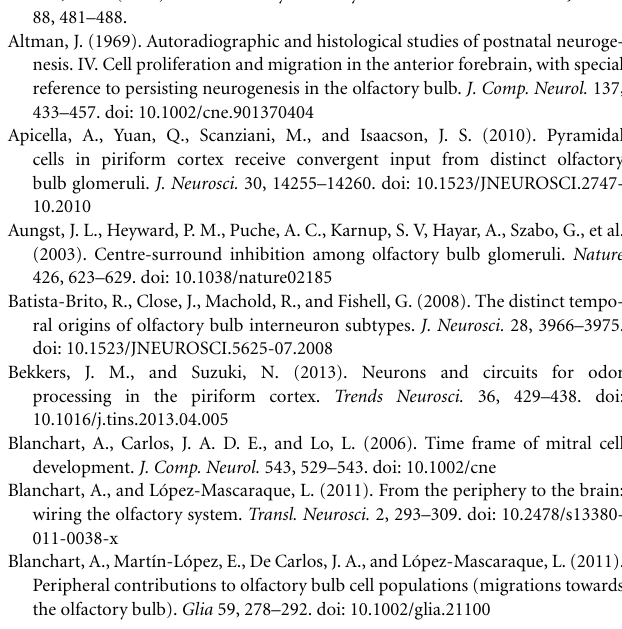
in utero electroporation of different plasmids with the UbC-Star Track method (Figueres-Oñate and López-Mascaraque, 2013). Note the presence of cells with either arachnoid morphologies, similar to those in (B) , and crescent-shaped cells similar to (C) . (D,E) . View of different morphological neuronal types. (F) Several neurons along with different glial